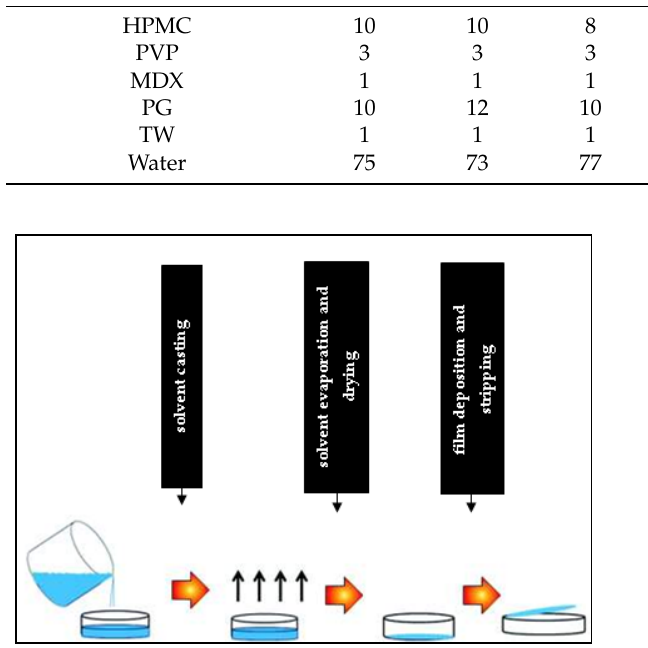
Figure 2. Solvent casting technique.